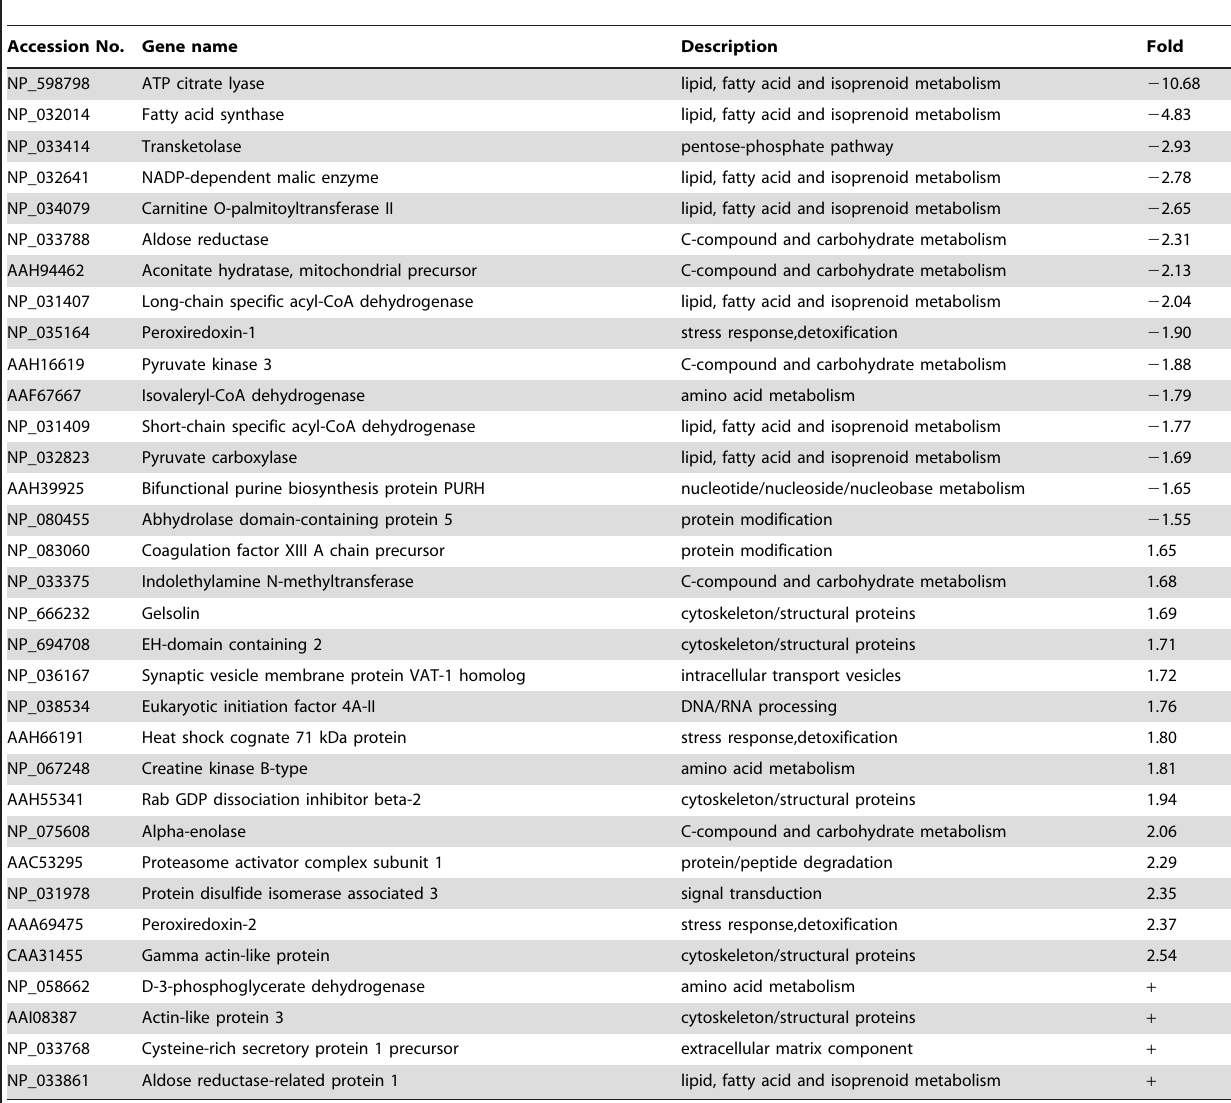
Table 1. Proteins with altered expression in the WAT of the HFD-fed mice at 4